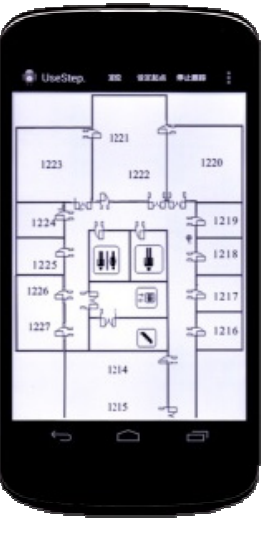
Figure 17. The proposed indoor positioning system running on Google Nexus